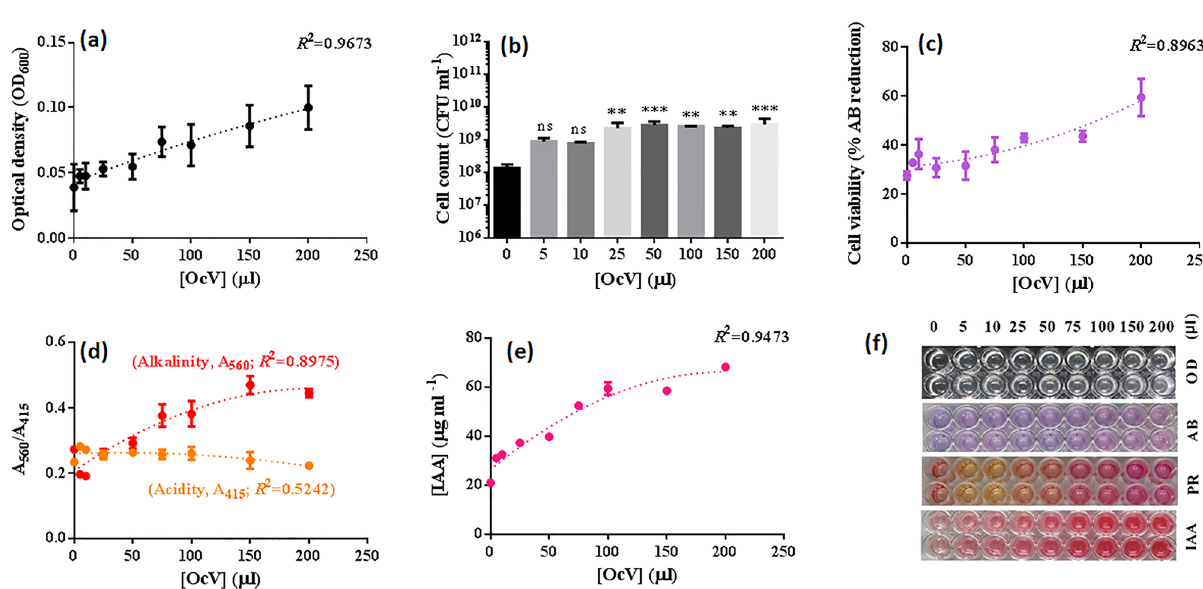
Figure 5. Influence of the vapors of 1-octanol (OcV) on Pseudomonas sp. NEEL19, cultured in DSMZ 125* containing 0.1% (w/v) Trp. Dose-dependent variation in ( a ) optical cell density (OD 600 ), ( b ) cultivable cell count, ( c ) cell viability, ( d ) media acidity/alkalinity and ( e ) IAA production, when supplied with 0 ‒ 200 µl 1-octanol (plate ‒ 1 ) as the volatile sole source of carbon and energy, are shown; BM W without OcV (0 µl) exposure was used as a control in ( b ). Microplate sections obtained in this study ( f , top-to-bottom) represent dose-dependent variation in turbidity ( a ), and chromogenic reactions of cell viability ( c ), media alkalization ( d ) and IAA production ( e ) assays. A 415 and A 560 , absorbances at 415 and 560, respectively. IAA, indole-3- acetic acid; OD, optical cell density; PR, phenol red; AB, alamarBlue. Error bar, mean (n = 4) ± s.d. ** P < 0.05, *** P < 0.01; ns,